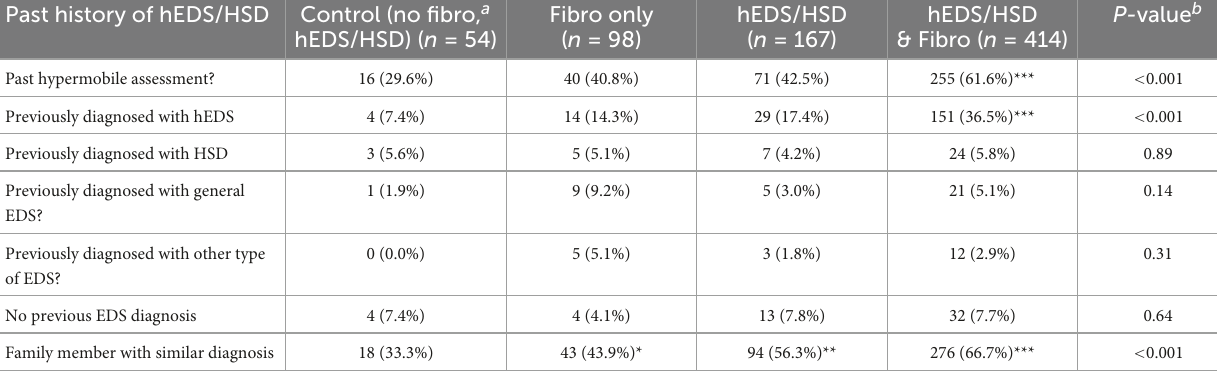
TABLE 2 Past history of hEDS/HSD in female and male patients diagnosed with fibromyalgia, hypermobility (hEDS or HSD), or hEDS/HSD and fibromyalgia compared to controls ( n = 733). Past history of hEDS/HSD Control (no fibro, a Fibro only hEDS/HSD hEDS/HSD) ( n = 54) ( n = 98) ( n = 167) Past hypermobile assessment?